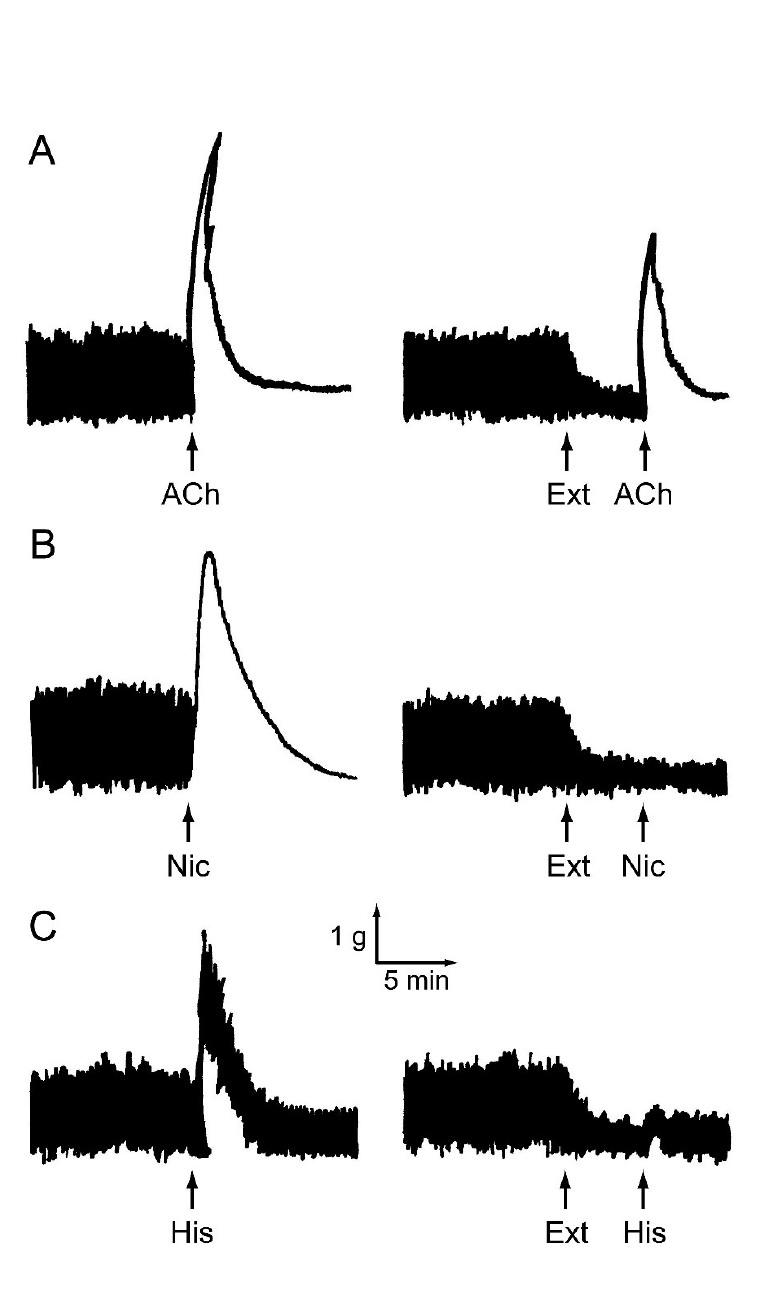
Figure 4. Effect of the protein-containing extract prepared from the venom ducts of P. albida (10 µg protein/mL) on the contractions induced by ( A ) 1 µM ACh, ( B ) 10 µM nicotine and ( C ) 0.5 µM histamine (right side). The tracings on the left side show the response induced by the agonists